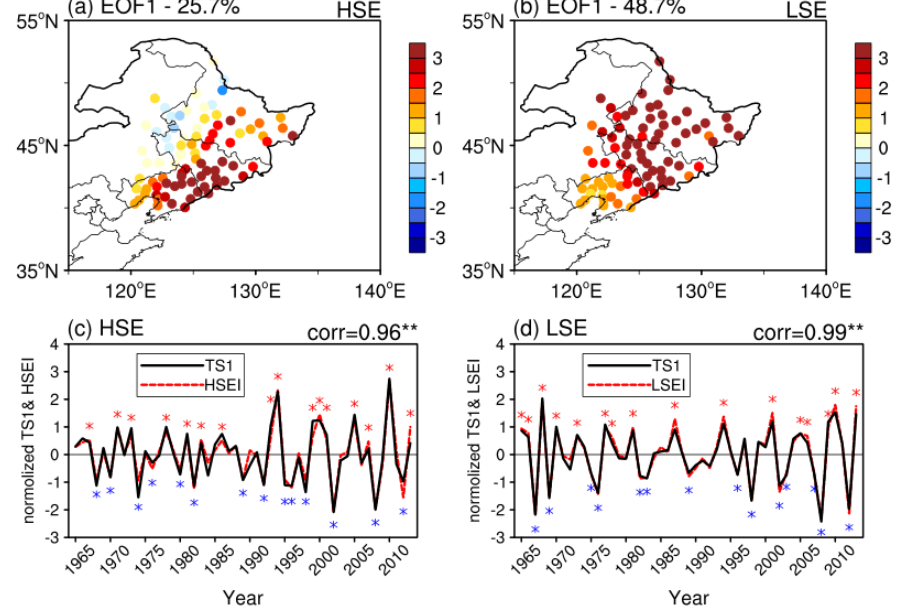
Figure 4. Leading empirical orthogonal function (EOF) (EOF1) of wintertime HSE and LSE and snowfall (HSE or LSE) index in NEC during 1965–2013, with each station normalized by its deviation before the EOF analysis: ( a ) spatial structure of the EOF1 of HSE anomalies; ( c ) normalized time series of the EOF1 of HSE anomalies (solid black line) and HSE index series (dotted red line); ( b , d ) as in ( a , c ) but for LSE. The variation explained by the EOF1 of HSE and LSE is 25.7% and 48.7%, respectively. Snowfall (HSE or LSE) index is normalized by the regional average over NEC. In ( c , d ), red and blue asterisks correspond to years with snowfall index larger than 0.5 standard deviations and lower than − 0.5 standard deviations, respectively, in which the correlation coe ffi cient between the EOF1 time series and the snowfall index series is presented on the top-right side, and the two black asterisks indicate the correlation coe ffi cient is above the 99% confidence level.